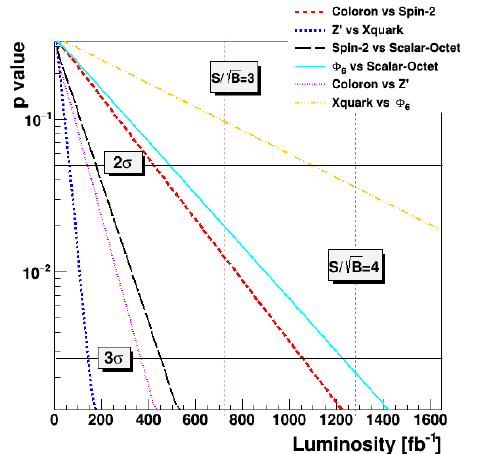
Figure 4 . The p -values testing hypothetical identities of various resonances as a function of lumi- nosity. Horizontal lines indicate 2 and 3 (cid:27) exclusion of the alternate hypothesis. Vertical lines show p where S= B = 3 or